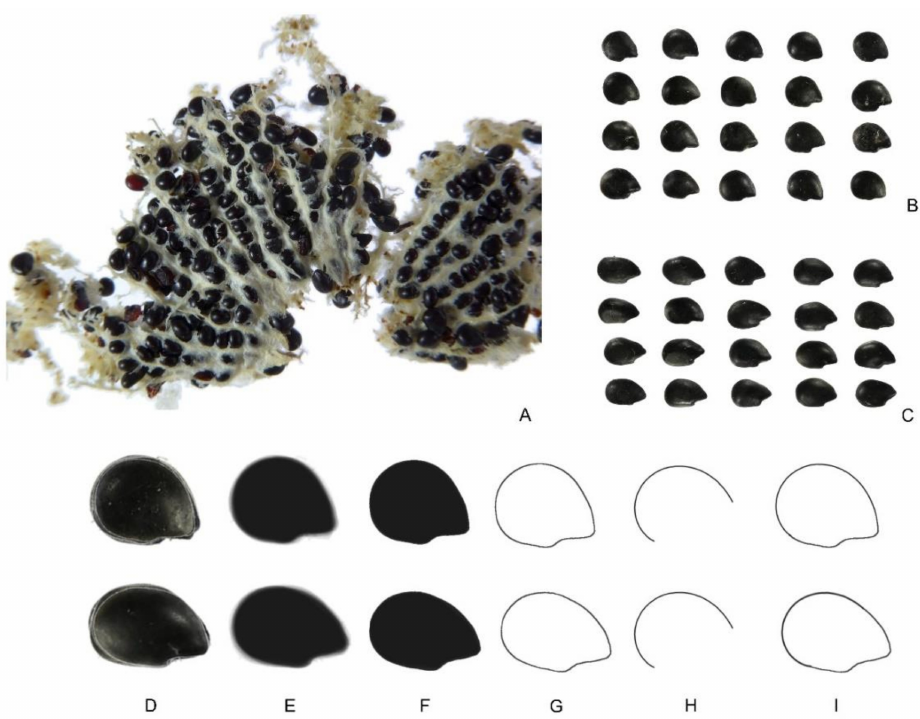
Figure 8. Echinocactus platyacanthus . ( A ) Seeds densely packaged in wool from an open fruit. The seeds have different orientations. ( B ) Short seeds; ( C ) Long seeds. Twenty seeds consisting of short (above) and long (below) types. ( D – F ) Successive steps to obtain the average silhouette. ( G ) Profile of the average silhouette. ( H ) Geometric curve used in the construction of the final model ( I ) for short (above) and long (below) seeds. Bars equal 1